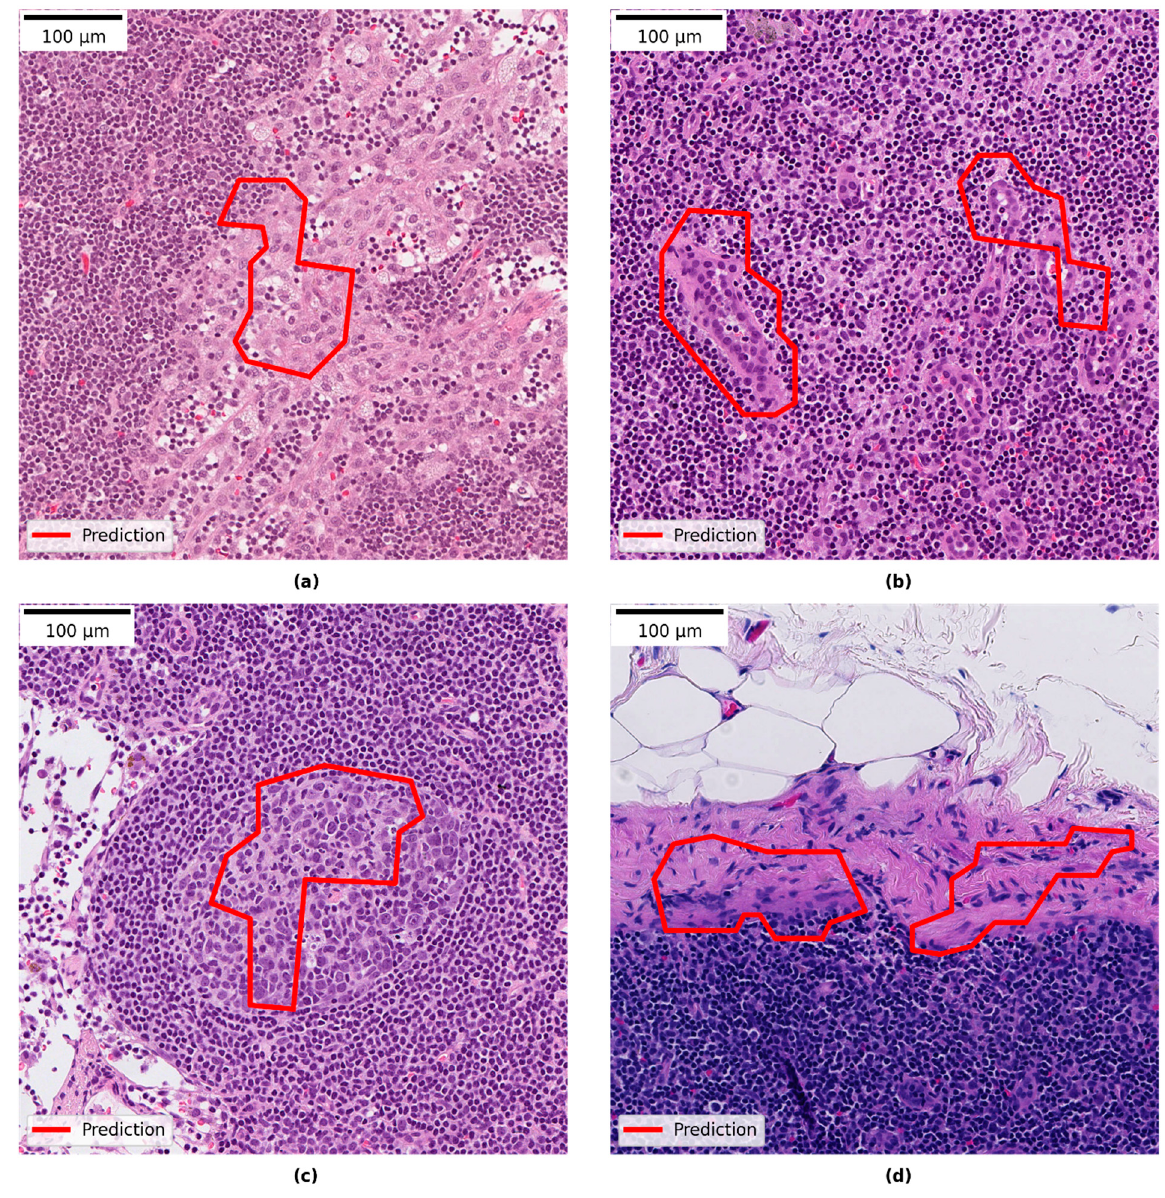
Figure 5. Examples of false positive areas: ( a ) histiocytes; ( b ) vascular elements; ( c ) germinal center; and ( d ) capsular region.